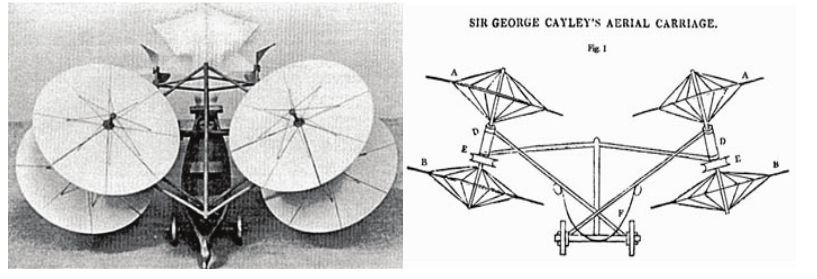
Figure 2 – Aerial carriage, 1843 Рис . 2 – Воздушная карета , 1843 г . Слика 2 – Ваздушна кочија из 1843.